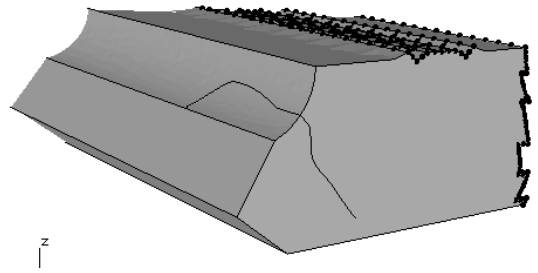
Figure 11. The 30° angle, short flank crack shape.